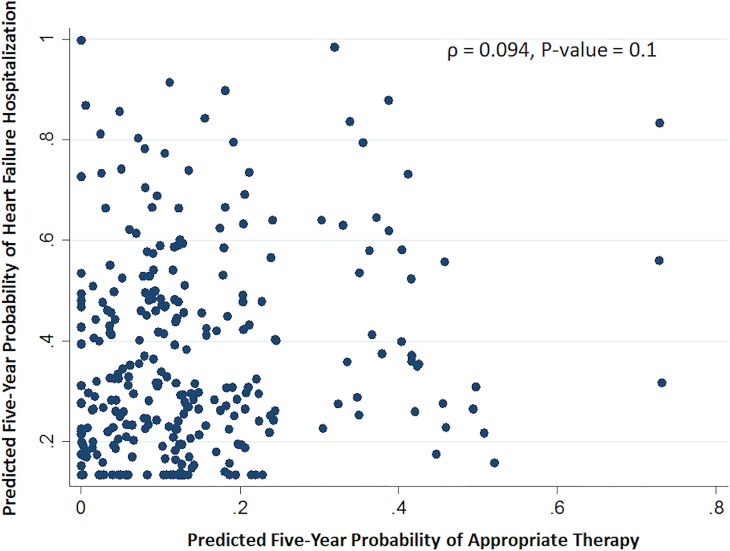
Scatter plot of five-year probability of HF hospitalization versus appropriate therapy.